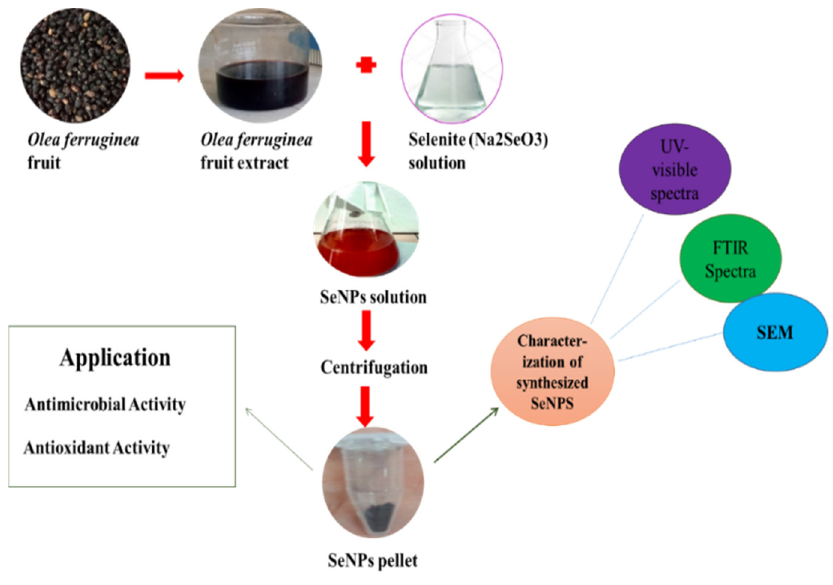
Figure 6. Synthesis of SeNPs from Olea ferruginea and their application as antibacterial and antioxi-